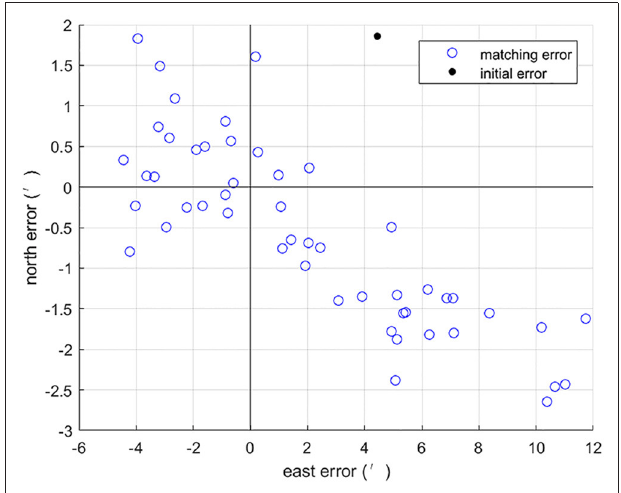
FIGURE 6 | Matched